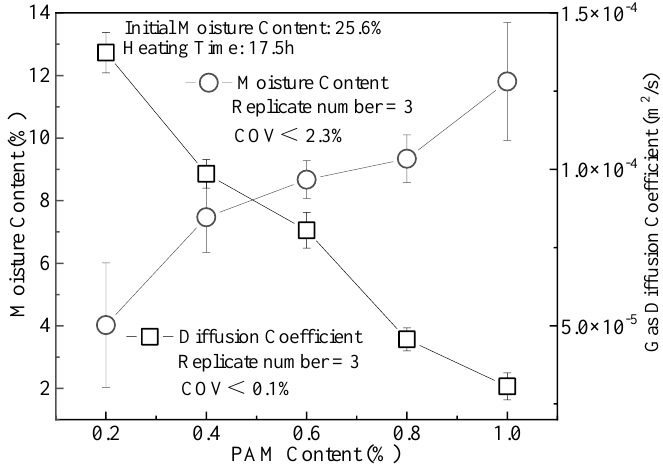
Figure 9. Influence of ZP content on the gas diffusion coefficient of the compacted clay.